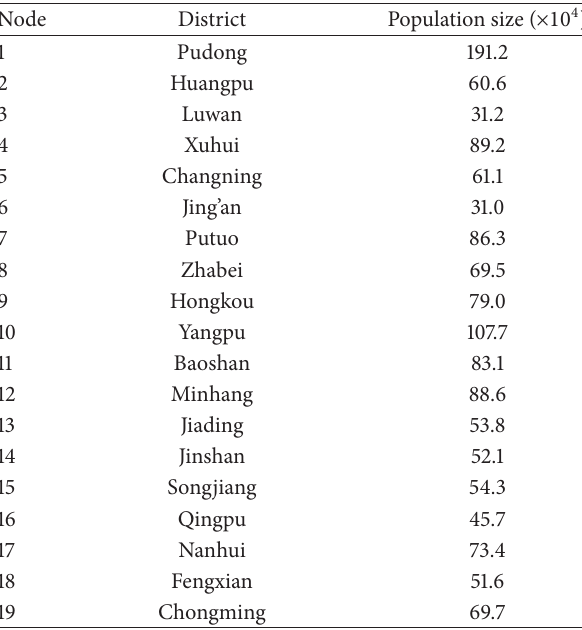
Table 2: The 19 districts and their population sizes.